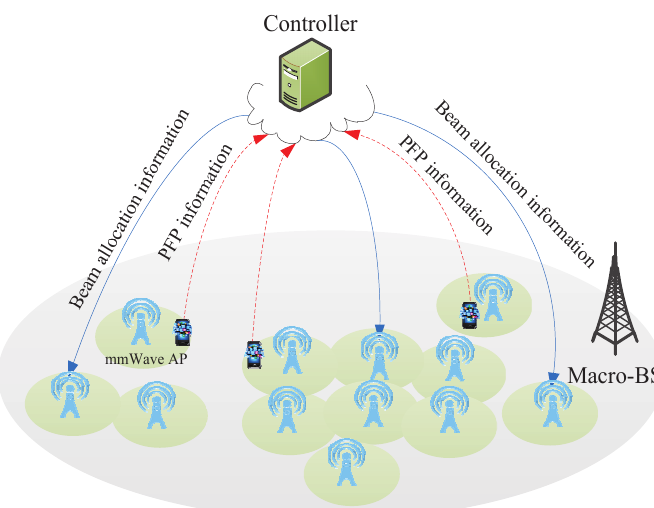
Figure 1. Millimeter wave heterogeneous